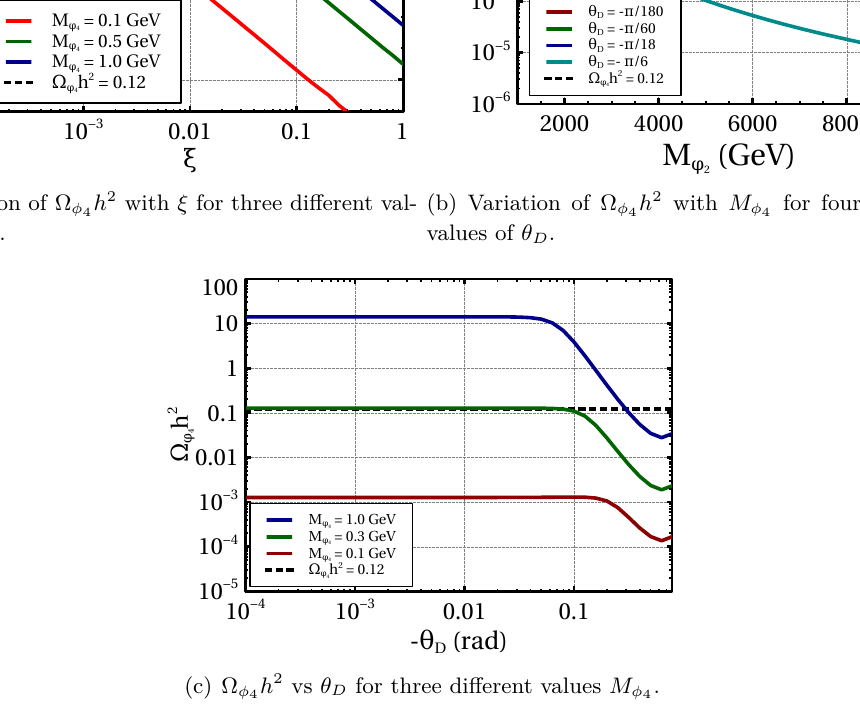
(c) Ω φ h 2 vs θ D for three different values M φ 4 Figure 7 . Variation of relic density with relevant model parameters.